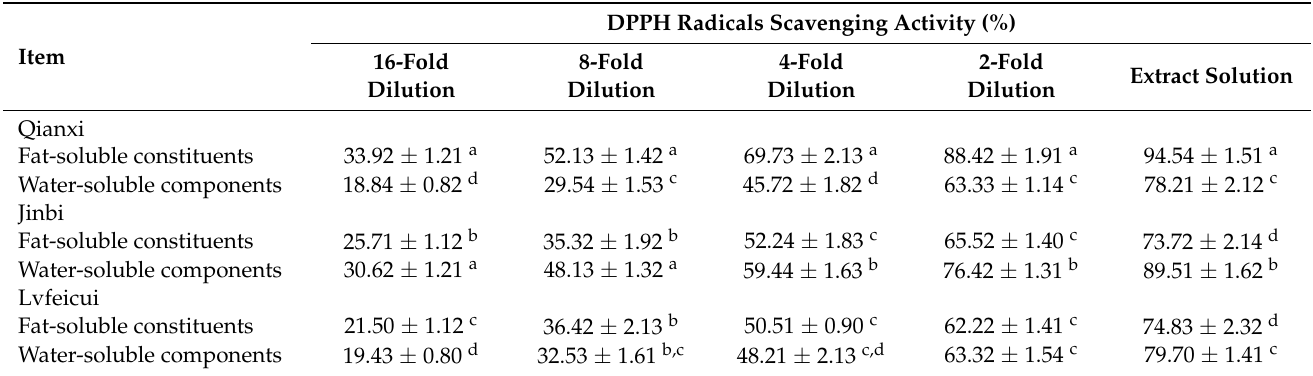
Table 4. Effects of scavenging DPPH radicals from three different cherry tomato varieties.